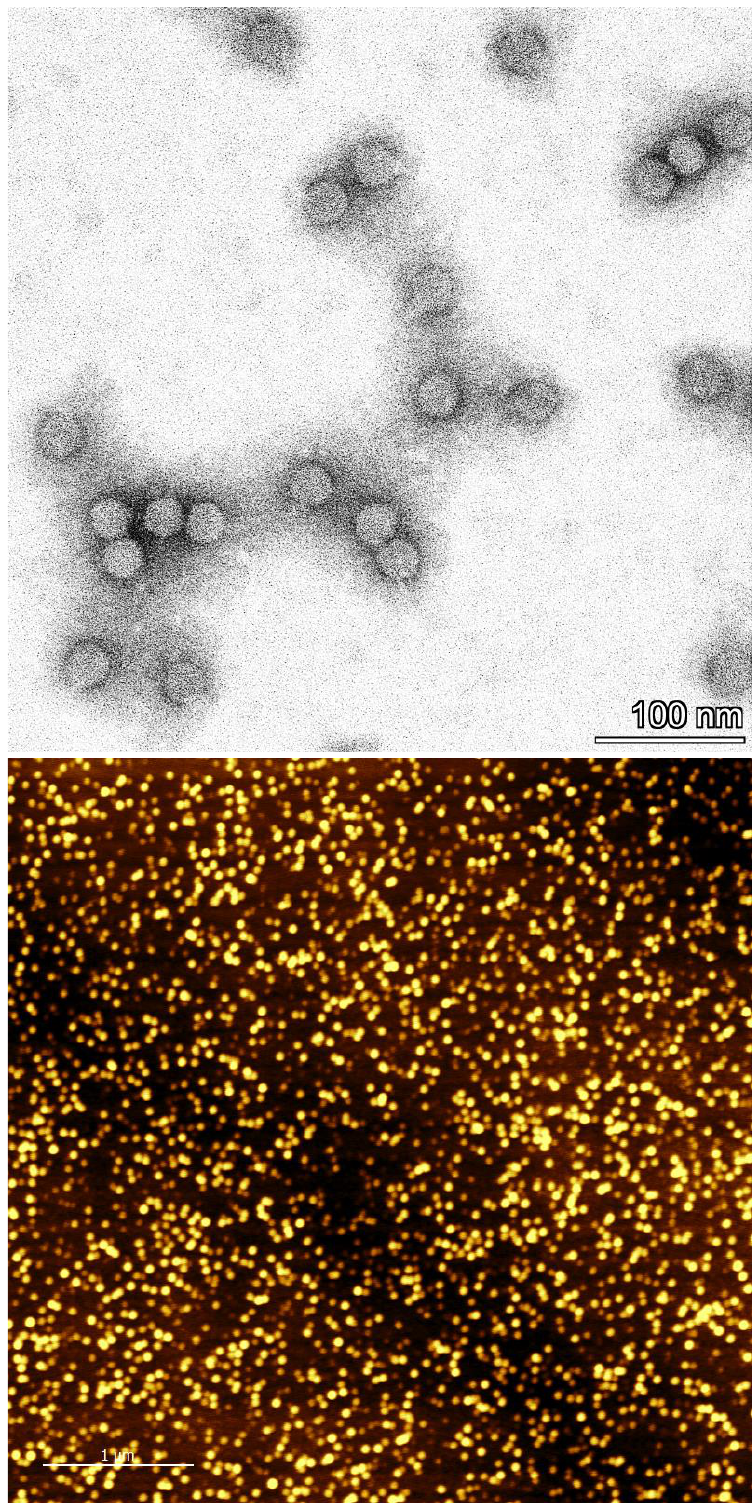
Figure 12. Representation of CCMV nanoparticles after affinity extraction. Top : Negative staining TEM image showing virions with a diameter of 28 nm. Bottom : AFM image.